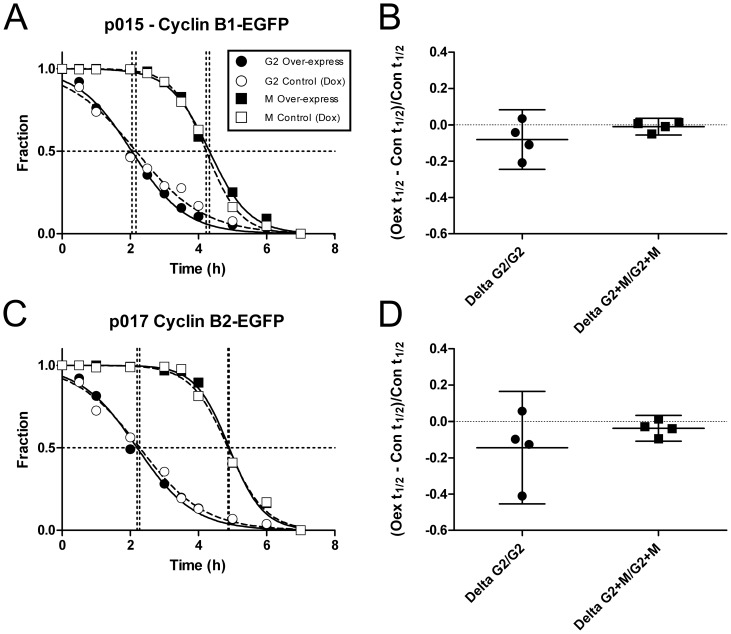
Over-expression of B cyclins does not alter G2 and M phase transition times.P006-14, p015-4 and p010-1, p017-4 cells were cultured with BrdU in the presence (Control) or absence of Dox (Over-express) to test the ability of B cyclin over-expression to decrease G2 transit and affect M transit. Cells were fixed, stained, and measured as in Figure 5. A, C: fractions of unlabeled G2 (circles) or M (squares) cells as a function of time in the absence (white symbols) or presence of Dox (black symbols). B, D: two experiments with p006-14, p015-4, p010-1, and p017-4 were analyzed as in A, C and the transit times calculated. To normalize the data the differences between Dox treated and untreated G2 and G2+M t1/2 values (dotted lines) were divided by the t1/2 for Control cells (Y axis). The data for G2 (Delta G2/G) and G2+M (Delta G2+M/G2+M) are denoted on the X axis. The results are not statistically different from 0 for any data set.